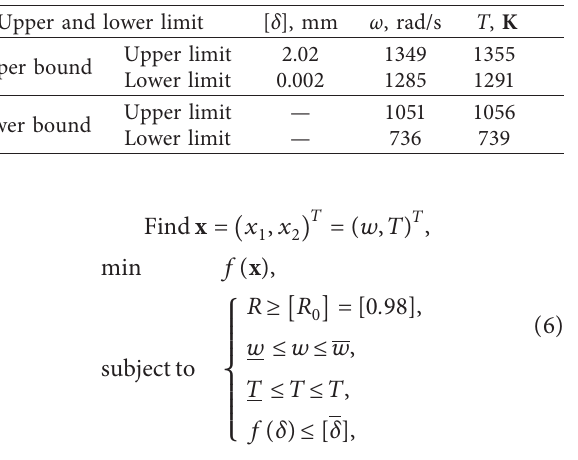
Table 2: Constraints of design parameters.